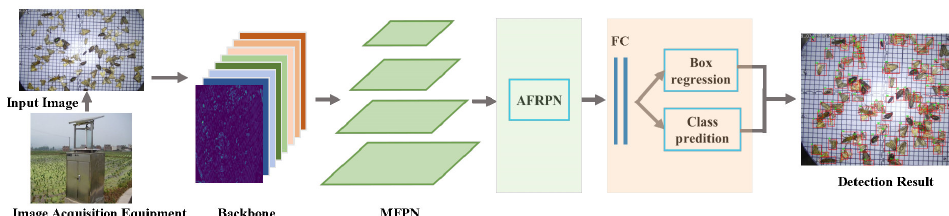
Figure 4. The technical pipeline of MCPD-net.